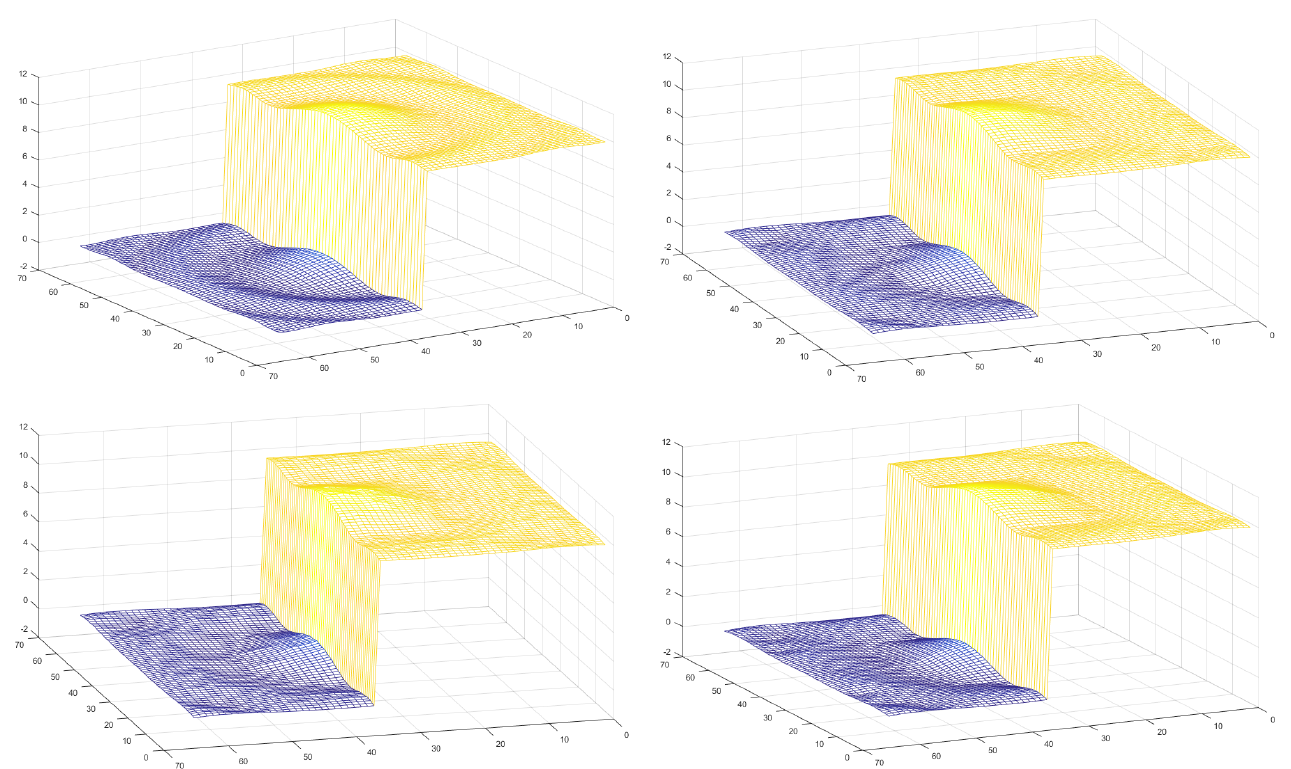
Figure 4. Obtained reconstructions after the compression (93%) and decompression process using 2 scales of different MR algorithms. Top-left: Original, Top-right: GM 1 , Bottom-left: GM 2 , Bottom-right: GM 3